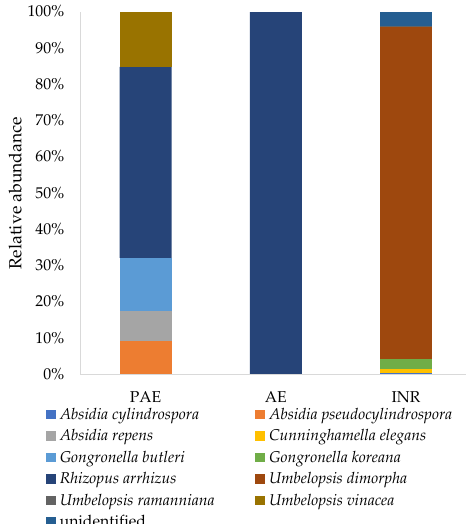
Figure 7. Abundance of the species belonging to Mucoromycota in soil samples taken from the Polluted AgroEcosystem (PAE), the AgroEcosystem (AE), and the integral natural reserve (INR) .